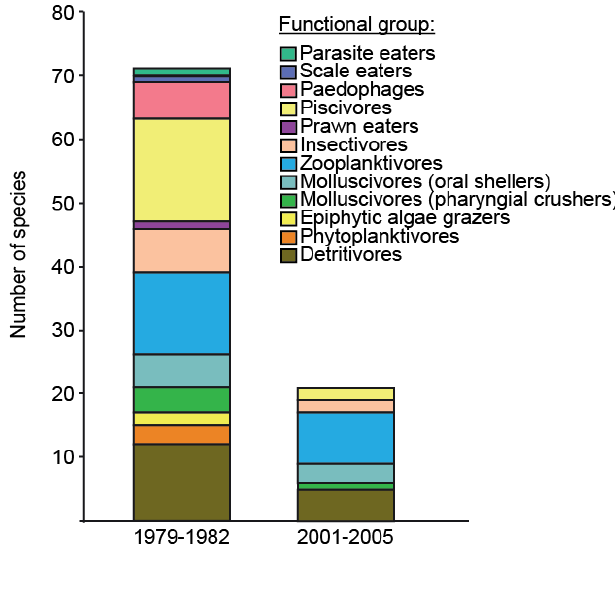
Fig. 4 . Species and functional diversity loss in the soft-bottom fish community of Lake Victoria. The bars represent the number of haplochromine species per functional group collected in the sublittoral waters (6–14 m) of the northern part of the Mwanza Gulf, over soft bottom, in 1979–1982 and 2001– 2005. Between 1979–1982 and 2001–2005, 65–70% of species and 50% of functional groups were irreversibly lost. One unclassified species is omitted here. Data from Witte et al. (2013). Not only does the number of functional group decrease, but the degree of specialization within trophic groups also decreases: e.g., former zooplanktivores have broader diets in 2001–2005 than in 1979–1982 (Kishe-Machumu 2012, van Rijssel and Witte